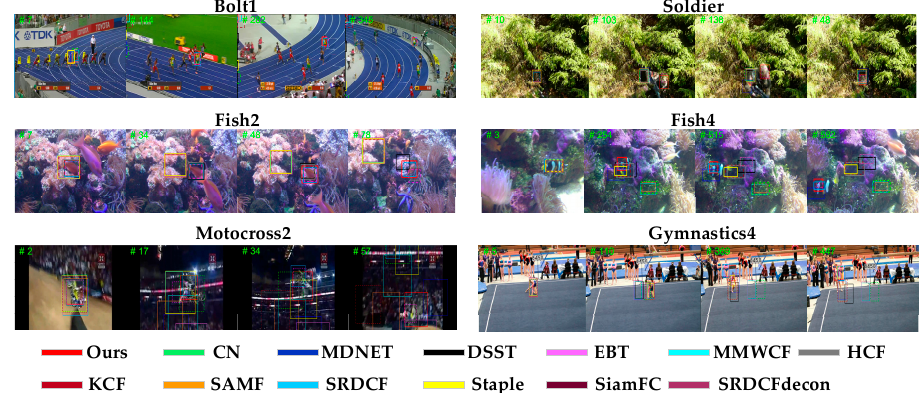
Figure 12. Qualitative evaluation on six video sequences (i.e., Bolt1, Soldier, Fish2, Fish4,